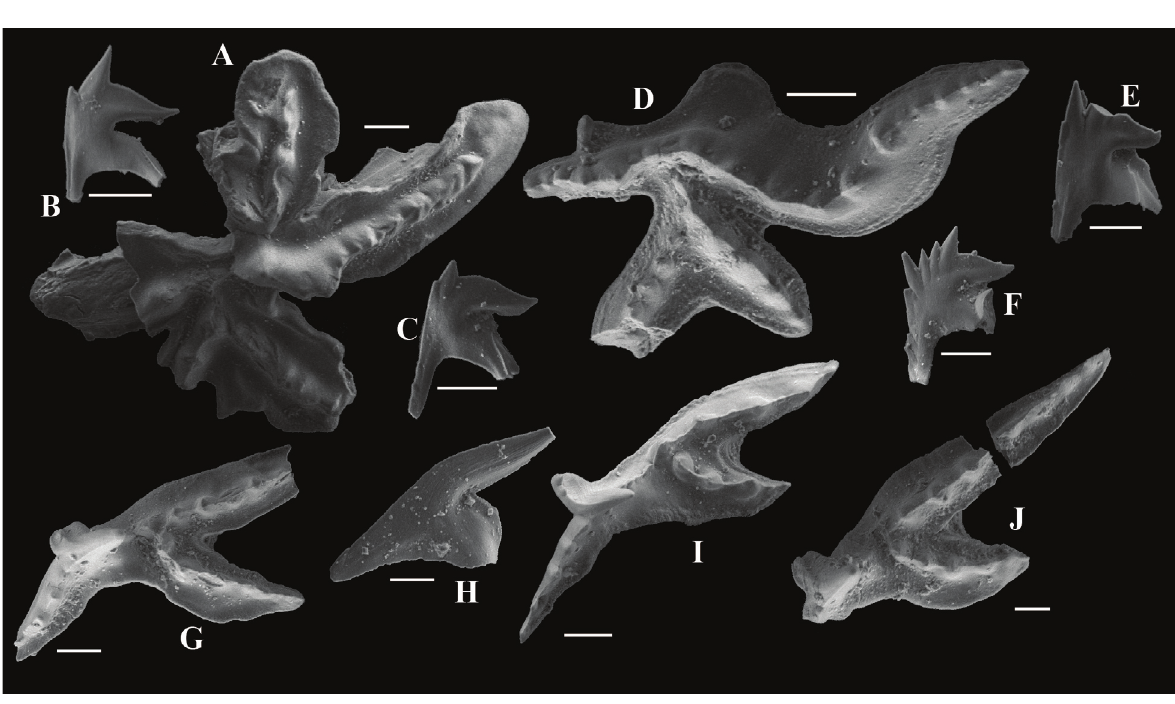
Fig. 4. Selected conodonts from the Mehikoorma (421) drill core. Scale bar represents 100 μm. A – F , Amorphognathus tvaerensis Bergström: A, D, P elements, 314.9–315.0 m ( Baltoniodus alobatus conodont Subzone) and 315.5–315.7 m ( Baltoniodus gerdae 1 conodont Subzone); B, C, M elements, 314.9–315.0 m ( Baltoniodus alobatus conodont Subzone); E, F, M elements, 319.75–319.85 m ( Baltoniodus gerdae conodont Subzone) and 320.8–320.9 m ( Baltoniodus variabilis conodont Subzone). G – J , Baltoniodus gerdae Bergström: G, H, P and M elements, 315.5–315.7 m; I, J, P elements, 319.75–319.85 1 1